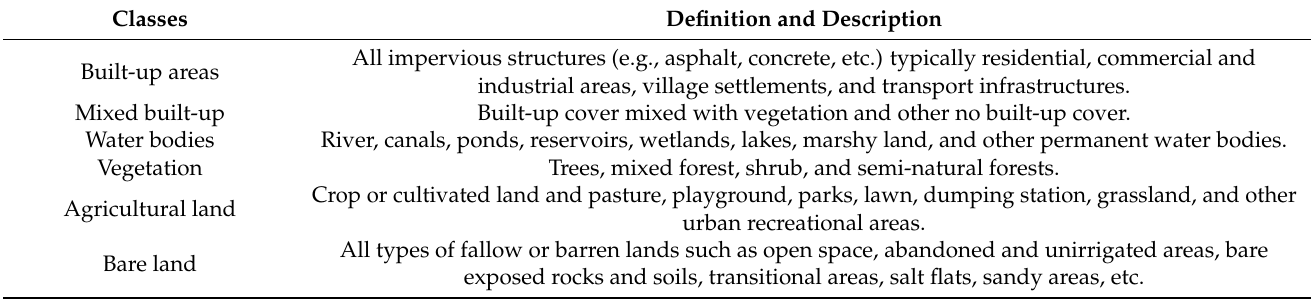
Table A2. The LULC classes and their corresponding description as adopted in the current study.